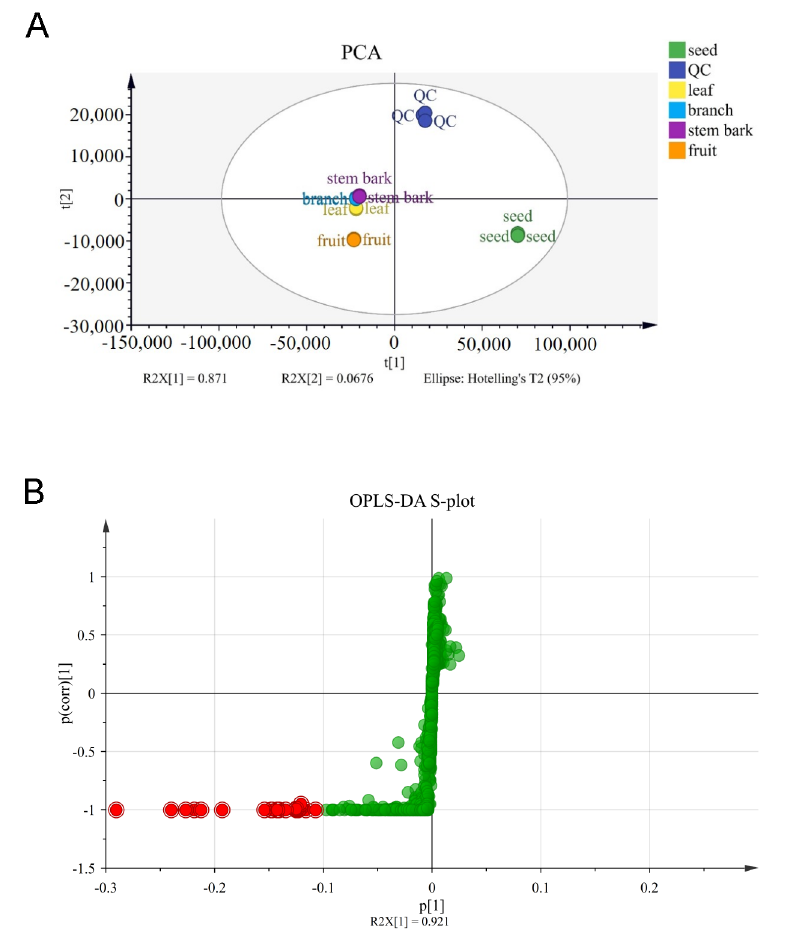
Figure 4. Multivariate analysis of different parts of G. xanthochymus . ( A ) Score plot from PCA (negative). ( B ) S-plot from OPLS-DA (negative). Compounds putatively identified in Table 2 are high- lighted. Table 2. Tentative identification of markers from bioactive fraction parts in seed extract.